Question: Write a single sentence explaining what this figure depicts.
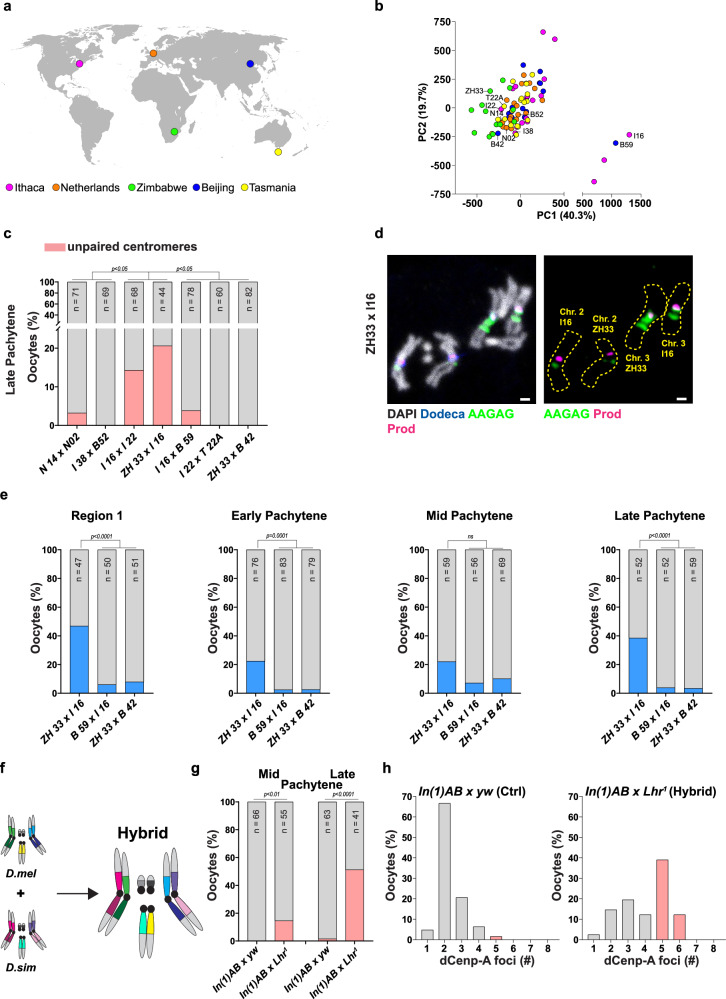
Answer: Satellite DNA divergence in naturally occurring populations leads to meiotic pairing defects. a Map indicating the geographical origin of strains from the Global Diversity Lines (GDL) collection. World base map adapted from Tonhar via Wikimedia Commons, licensed under CC0 1.0. b Principal component analysis (PCA) of satellite DNA content from the GDL strains based on previous estimates60. c Quantification of oocytes with >4 dCenp-A foci, indicating unpaired centromeres, in late pachytene in the indicated genotypes. d FISH against the Dodeca satellite repeat (blue), (AAGAG) n satellite repeat (green), Prod/(AATAACATAG) n satellite repeat (magenta) co-stained with DAPI (white) on mitotic chromosomes in the progeny of ZH 33 and I 16 strains. e Quantification of oocytes with unpaired Rsp loci in Region 1, early, mid, and late pachytene from the indicated genotypes. f Schematic of satellite DNA barcode mismatches in inter-species hybrids. g Quantification of oocytes with > 4 dCenp-A foci, indicating unpaired centromeres, in mid (left) and late pachytene (right) in the indicated genotypes. h Histogram showing the distribution of the number of dCenp-A foci in late pachytene oocytes from the hybrid and the pure species control from ( g ). n indicates the number of oocytes analysed, and p- values were obtained from a two-sided Fisher’s exact test. ns indicates p > 0.05. Source data are provided as a Source Data file. p- values of individual comparisons can be found in Supplementary Data 1 .